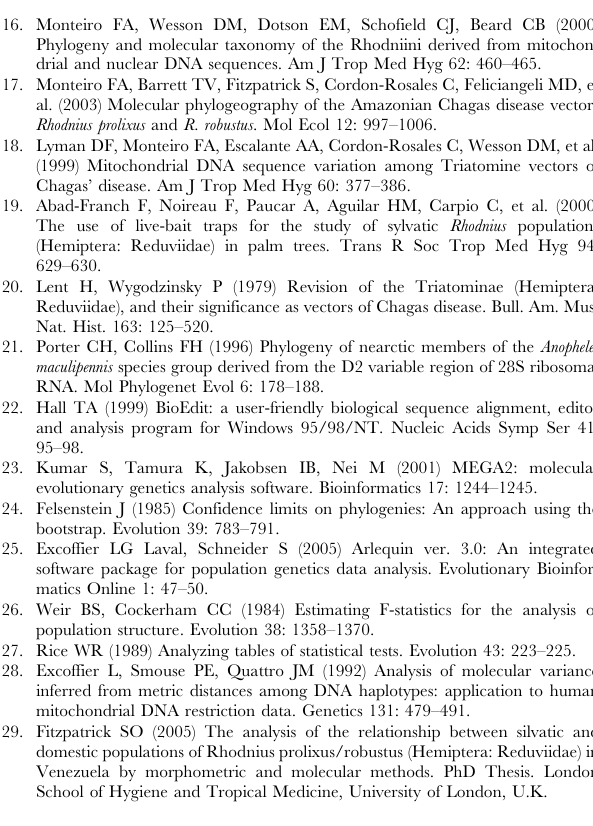
Table S1 The pairwise comparison of 34 populations from six Venezuelan States by cytb analysis; F ST values below diagonal (p- values above) (Arlequin v3.1). Values in bold remain significant following sequential Bonferroni correction (k= 561, p1 = 0.05/ 561, p # 0.0001). See Table 1 for population details. Table S2 Summary of population microsatellite data. (A) Summary of population microsatellite data per locus (LIST14- 056, LIST14-017, LIST14-042, LIST14-010, LIST14-064). N = number of specimens amplified, N A = number of alleles, H O , H E = Observed and Expected heterozygosity, P = exact probability for expected Hardy Weinberg equilibrium conditions for each locus/population combination (Arlequin v2.1), M = monomorphic. F IS = Weir & Cockerham (1984) (GENEPOP V3.4). Values in bold departures from HWE significant after Bonferroni correction (populations analysed at 9 loci k = 9, population details. (B) Summary of population microsatellite data per locus (LIST14-013, LIST14-021, LIST14-025, LIST14-037, LIST14-079). N= number of specimens amplified, N A = number of alleles, H O , H E = Observed and Expected heterozygosity, P = exact probability for expected Hardy Weinberg equilibrium conditions for each locus/population combination (Arlequin